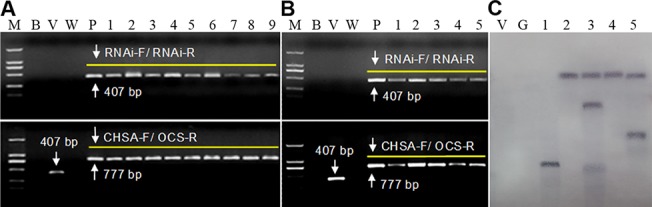
Molecular analysis of transgenic tomato plants.(A) Independently derived transgenic lines were detected via PCR using the primers RNAi-F/RNAi-R and CHSA-F/OCS-R (lanes 1–9: independent Rs-crt transgenic lines). (B) Independent transgenic lines were detected via RT-PCR using the primers RNAi-F/RNAi-R (lanes 1–5: RNA from Rs-crt transgenic lines 1, 2, 3, 4 and 5). M, DNA marker (DL2000); B, blank control without template; V, empty transformation vector plant; W, wild-type plant (negative control); P, positive plasmid control. (C) Southern blot analysis of NdeI-digested gDNA from T0 transgenic plant leaves (lanes v and g: gDNA from empty transformation vector plants and egfp transgenic plants (controls); lanes 1–5, gDNA from Rs-crt transgenic lines 1, 2, 3, 4 and 5).